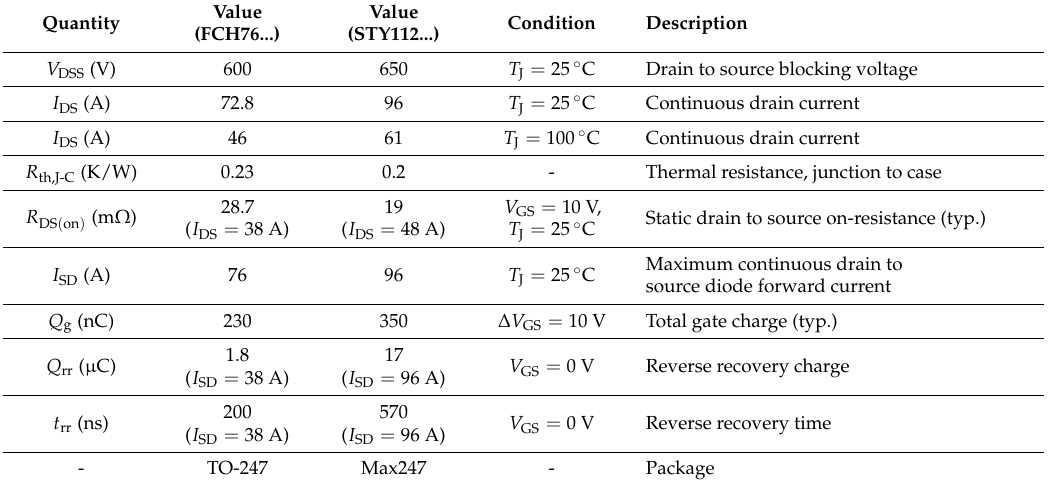
Table A1. Most relevant parameters of the FCH76N60NF high-voltage super-junction MOSFETs